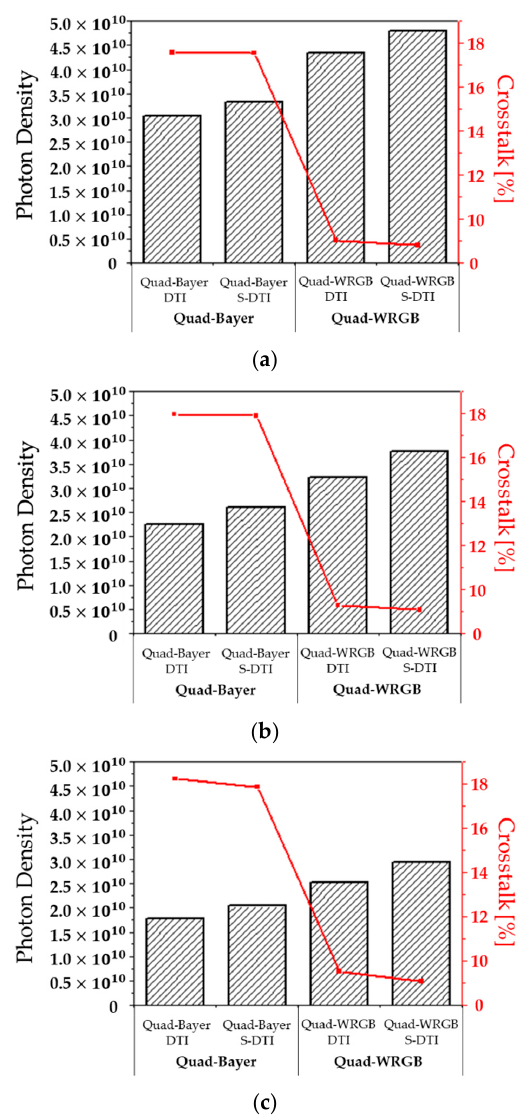
Figure 4. Simulation results of the photon density and the crosstalk in the 1.0 μ m, 0.9 μ m, and 0.8 μ m pixel pitches. The photon density is shown by the black diagonal striped bars, and the crosstalk is shown by the red solid lines. ( a ) 1.0 μ m pixel, ( b ) 0.9 μ m pixel, ( c ) 0.8 μ m pixel.